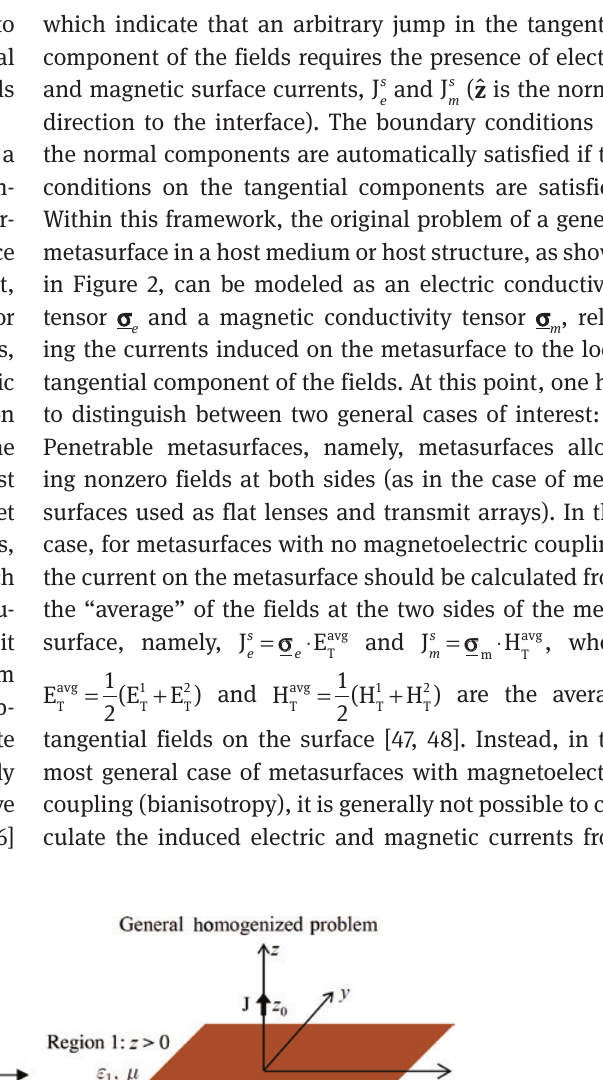
and magnetic conductivity tensor σ . Adapted with permission e m